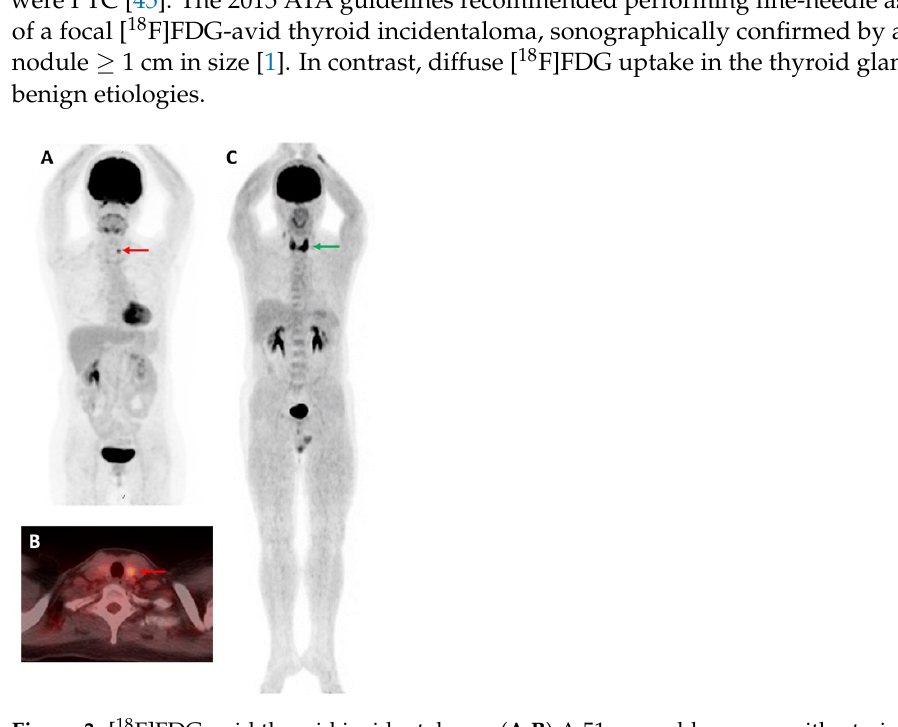
Figure 3. [ 18 F]FDG-avid thyroid incidentaloma. ( A , B ) A 51-year-old woman with uterine cervical cancer on surveillance. [ 18 F]FDG MIP skull-to-mid-thigh PET ( A ) and axial fused PET/CT ( B ) images showed focal [ 18 F]FDG uptake in the left thyroid lobe (red arrow). She underwent left thyroid lobectomy and the pathological diagnosis was PTC. ( C ) A 56-year-old man with a fever of unknown origin. [ 18 F]FDG MIP whole-body PET image revealed diffuse [ 18 F]FDG uptake of the thyroid gland (green arrow). After investigation, he was diagnosed with subacute thyroiditis.